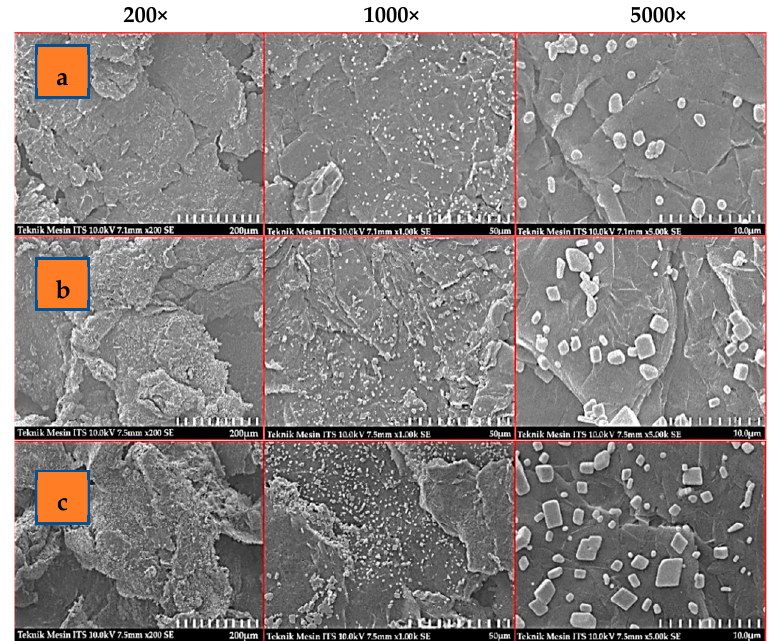
Figure 4. Observation results using scanning electron microscopy with a magnification of (200 times, 1000 times, and 5000 times) at ( a ) 6 V, ( b ) 9 V, and ( c ) 12 V.